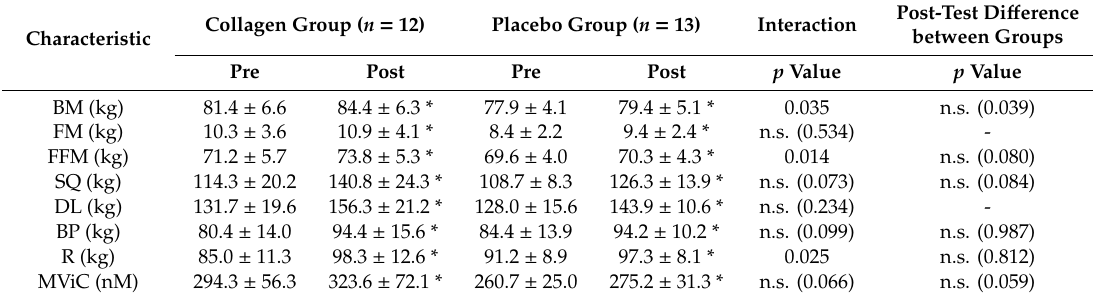
Table 1. Results for body mass (BM), fat mass (FM), fat free mass (FFM), the squat test (SQ), dead lift (DL), bench press (BP), rowing (R), and isometric strength testing (MViC) before and after the 12-week intervention period. Data are presented for the collagen and placebo groups (means ± SD) as a pre- and post-test comparison. Statistical significance for interactions as determined by ANOVA was considered as p ≤ 0.05, and the level of significance for the post-hoc t -tests was set at p ≤ 0.0125 after Bonferroni correction.